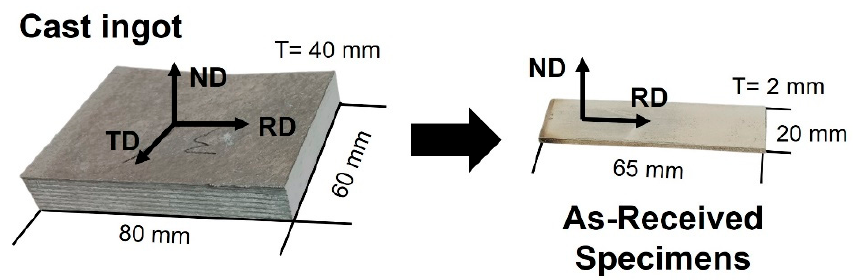
Figure 1. Images of the specimen of cast ingot and the as-received specimen.